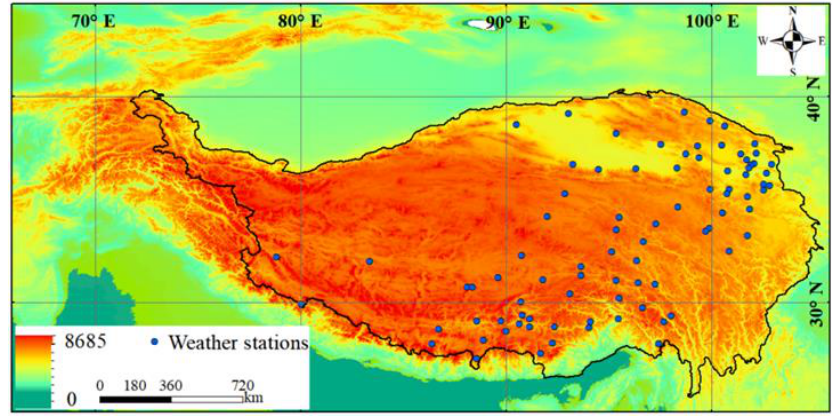
Figure 1. Study area.